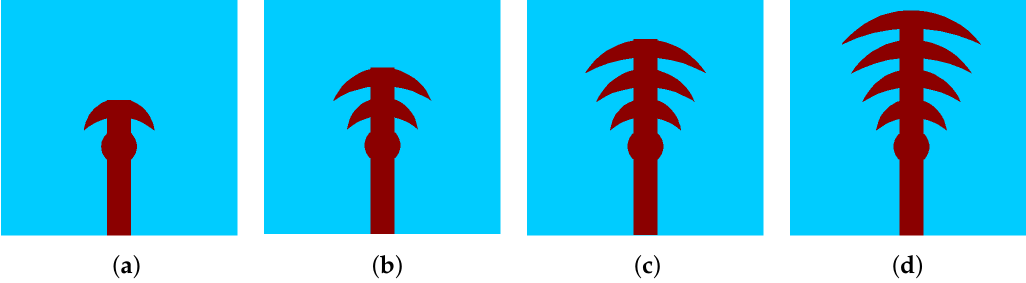
Figure 4. Geometrical design evolution steps of the proposed wideband antenna element. ( a ) step 1